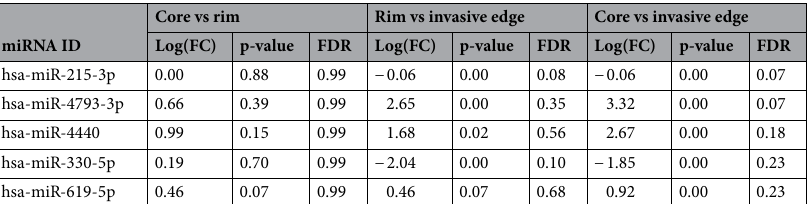
Table 1. Relative expression levels of differentially expressed miRNAs within the GBM tumour. miRNA expression for paired samples from 15 patients. Negative log2 transformed fold change (FC) values represent lower expression levels in the region written first. FDR false discovery